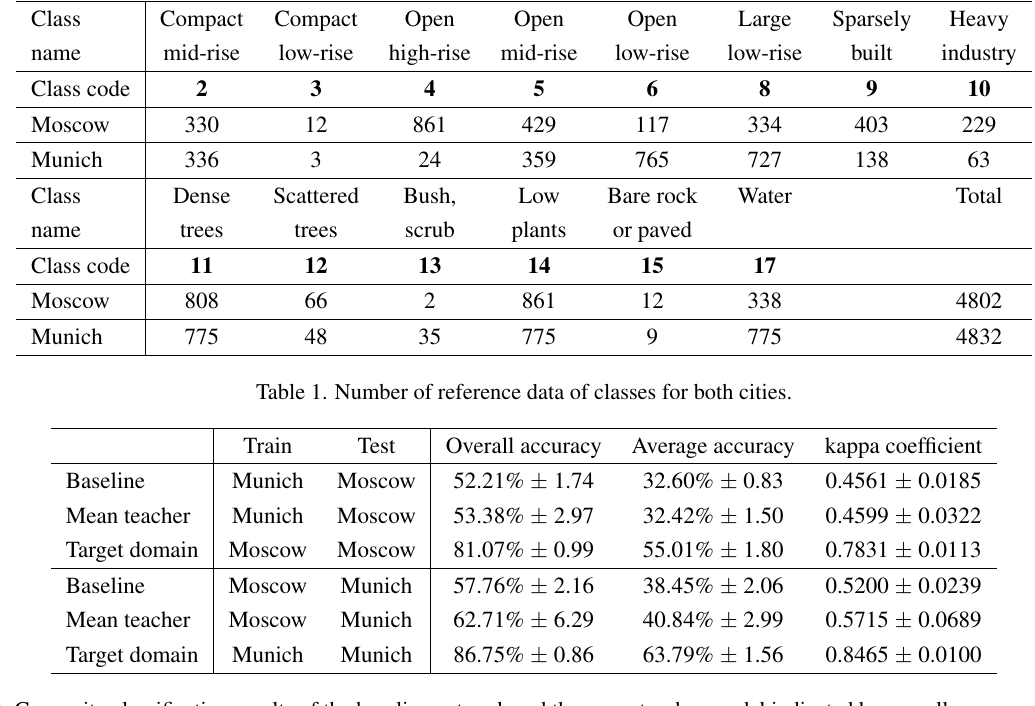
Table 2. Cross-city classification results of the baseline network and the mean teacher model indicated by overall accuracy, average accuracy, and kappa coefficient. The accuracy of the target domain are the results of training and testing on the target city, which demonstrate the best achievable results. The numbers are the mean value of ten independent experiments with the standard deviation following the ” ± ”